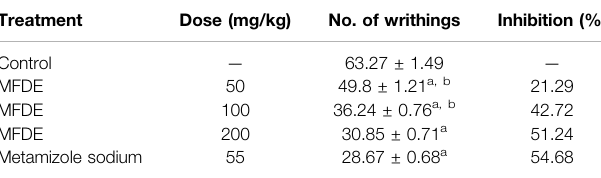
TABLE 4 | Effect of the MFDE on pain induced by acetic acid in